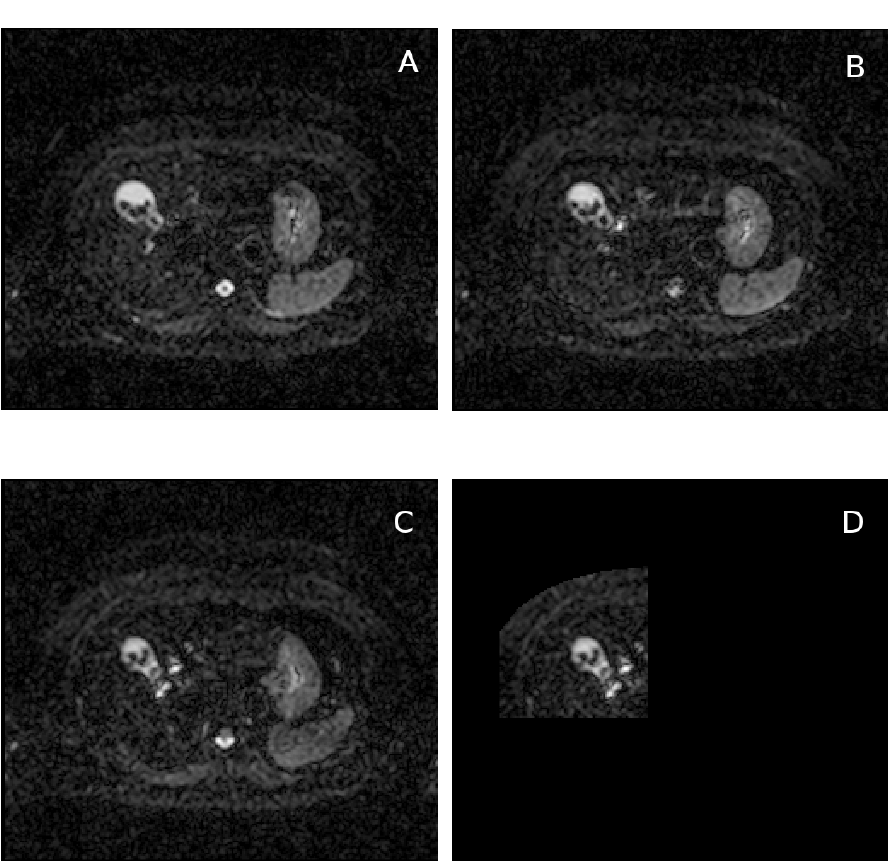
Fig 2. Diffusion gradient direction components of DW-MR data and the reference image. Healthy liver DW-MR image data (v3-0528-slc24); b-value = 100 s / mm 2 ; selected image slice from one of the repeat data- sets (out of 4) and diffusion gradients in y (A) and z (B) directions; diffusion gradient in − x direction which has been used as the reference image slice for local-rigid alignment (C) and the reference image shown in the selected ROI (D); this ROI is used both in local-rigid alignment and ADC histogram analysis; gamma